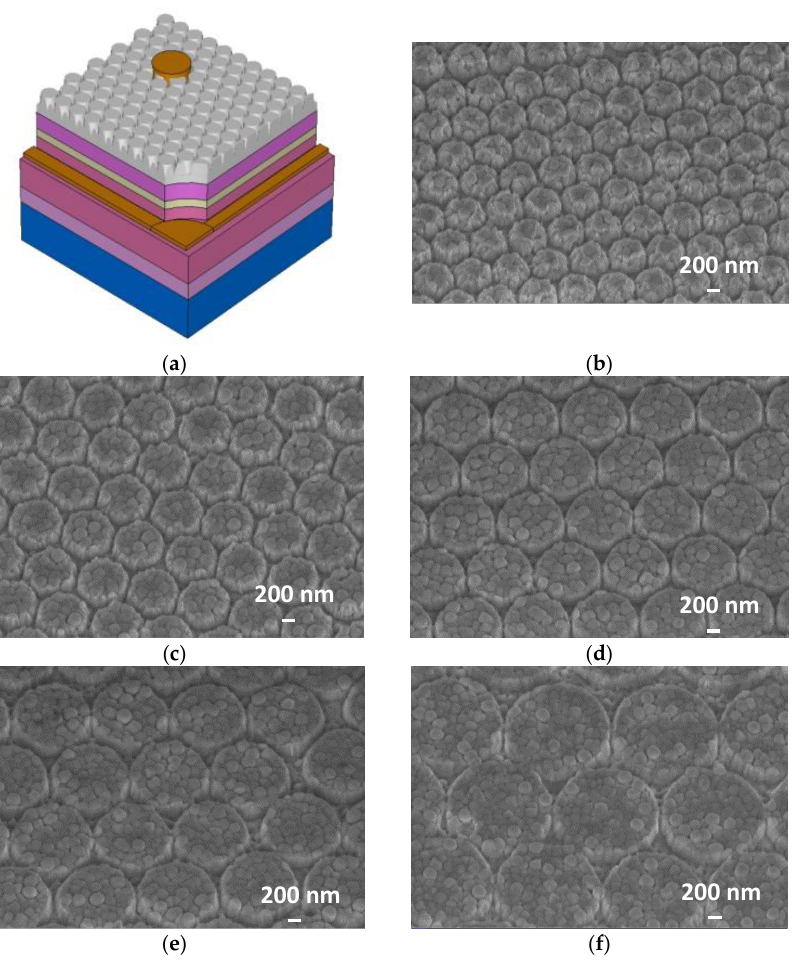
Commented [M1]: Please change Figure 1 into this one.